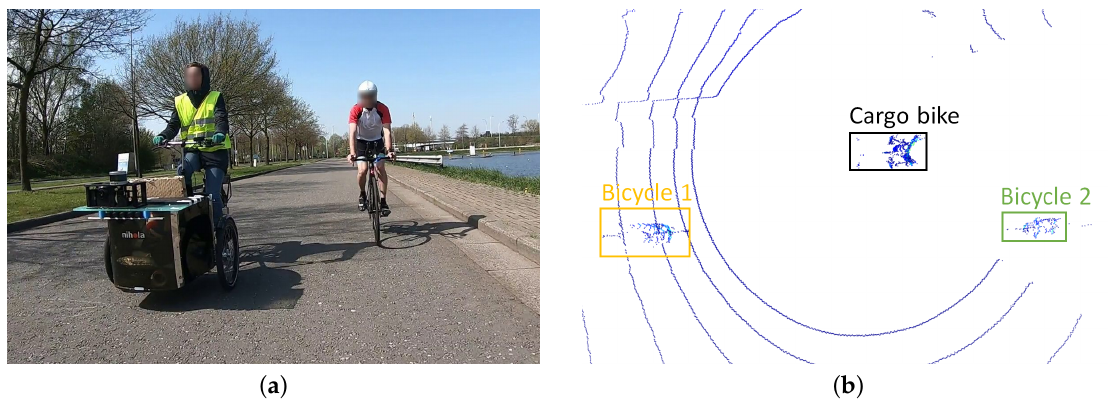
Figure 11. Example of dynamic distance calculation test. An electric cargo bicycle with mounted Light Detection And Ranging (LiDAR) scanner drives next to the cyclists. The LiDAR data provides ground truth for the distance determination. ( a ) Input image from the camera mounted on Bicycle 1; ( b ) top view of the LiDAR scanlines.